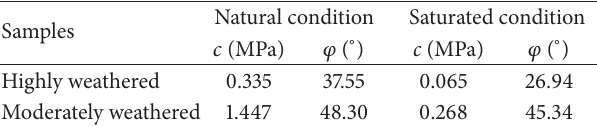
Table 2: Shear strength parameters of the silty mudstones under different